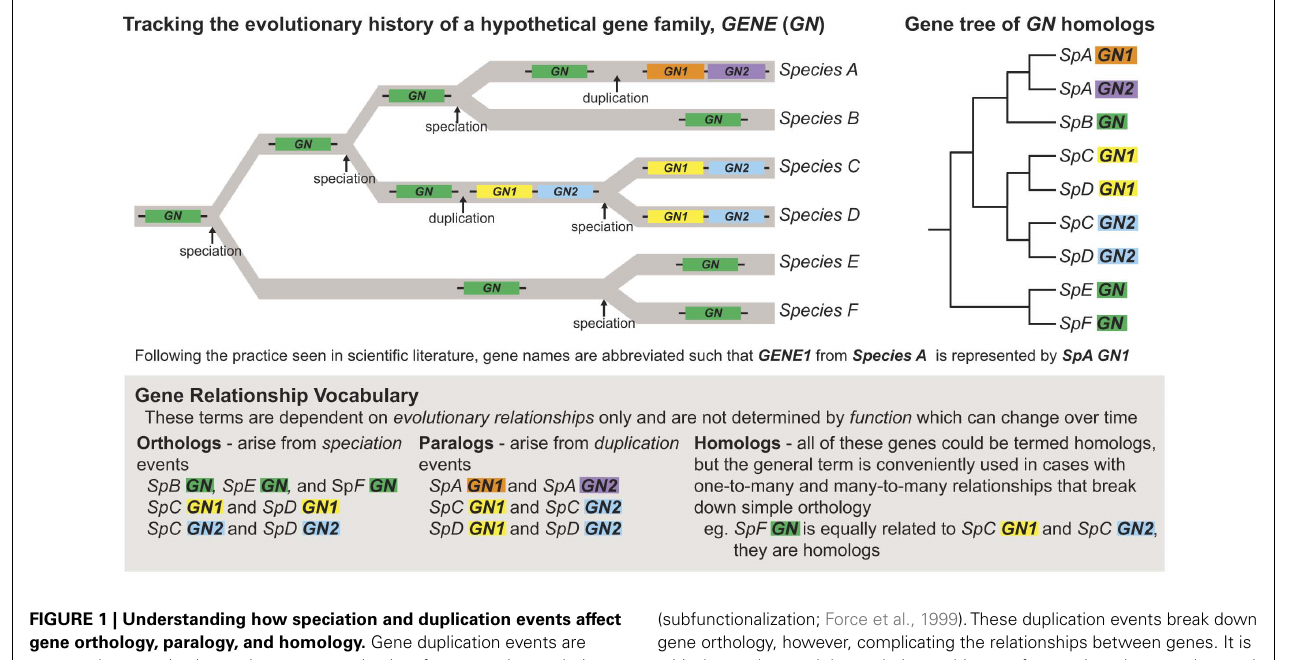
(subfunctionalization; Force et al., 1999).These duplication events break down gene orthology, however, complicating the relationships between genes. It is critical to understand the evolutionary history of genes in order to understand how their function has evolved through time, especially when comparing function of gene homologs generated via multiple duplication events in which the processes of neo and/or subfunctionalization may have